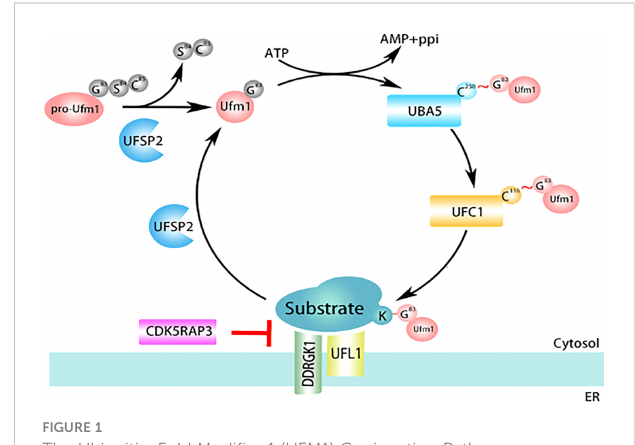
FIGURE 1 The Ubiquitin-Fold Modi fi er 1 (UFM1) Conjugation